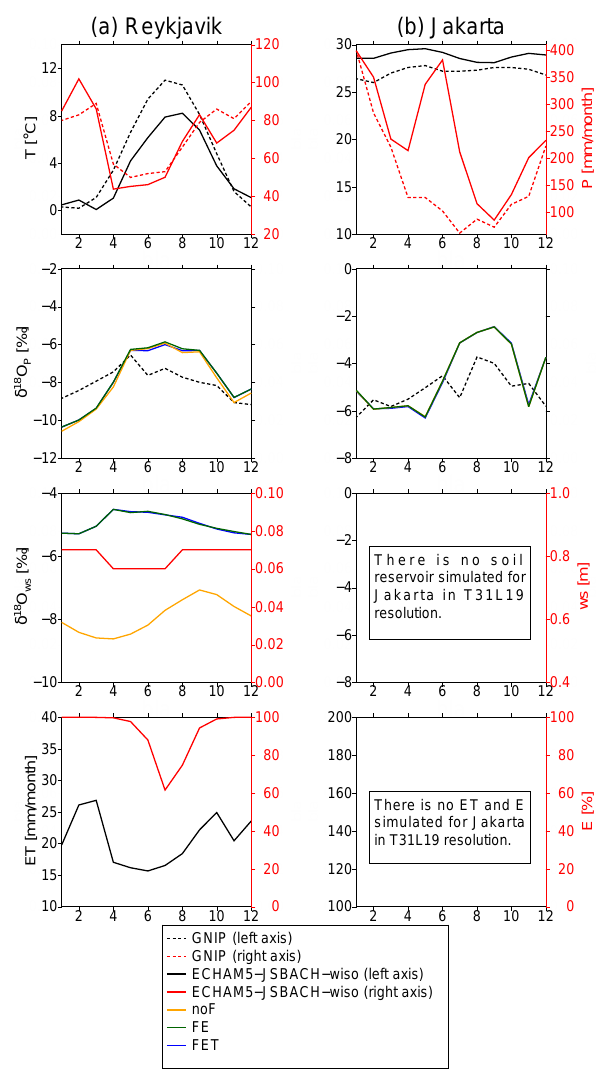
Fig. 10. Seasonal cycles of surface temperature T , precipitation amount P , isotopic composition of precipitation δ 18 O P , isotopic composition of soil water δ 18 O ws , depth of soil water bucket reservoir ws , evapotranspiration from land surface ET, and fraction of evaporation E for the locations (a) Reykjavik, (b) Jakarta. The dotted lines represent the observational GNIP values (left=black, right=red). For the simulations the black/red lines represent the simulated T , P , ET, ws and the fraction of evaporation. The simulated δ 18 O values in precipitation and the soil water bucket reservoir are the yellow (noF), green (FE) and blue (FET)